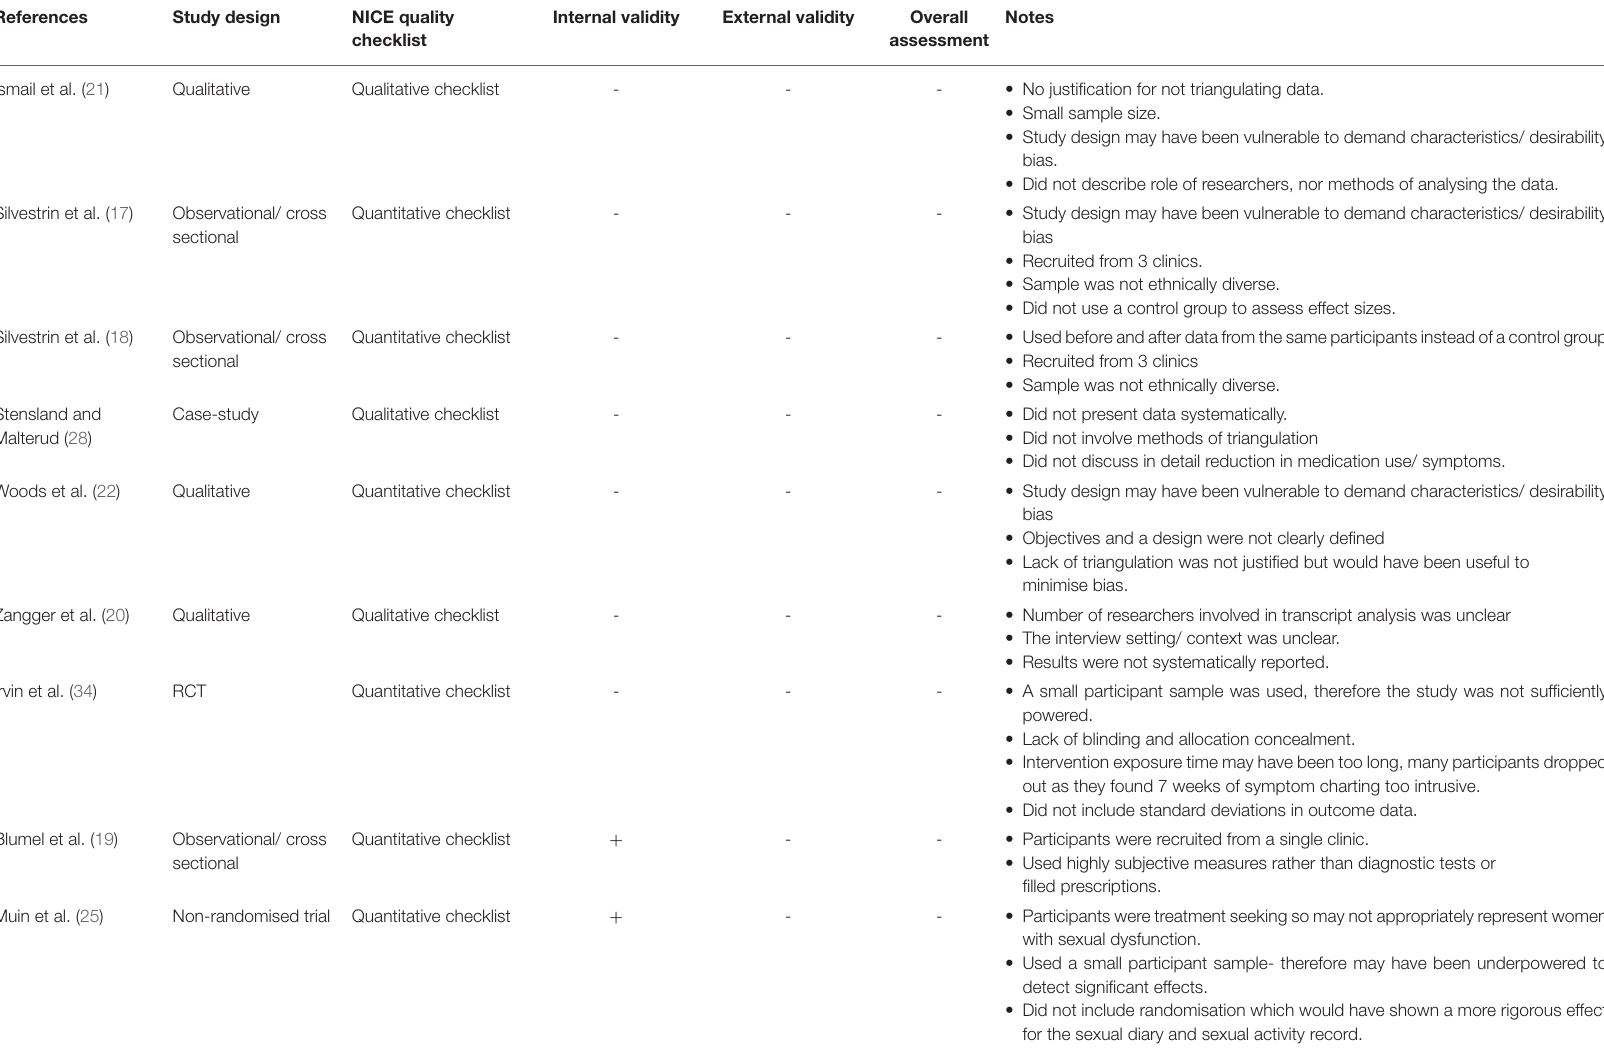
TABLE 2 | Quality assessment